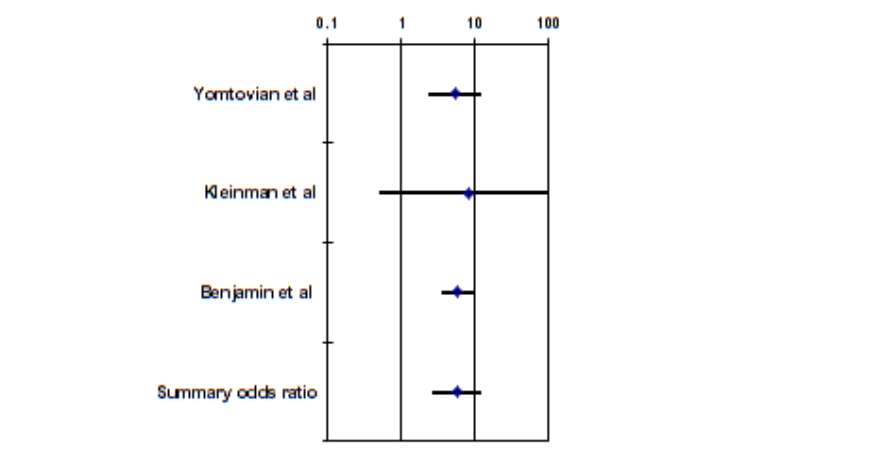
FIGURE 1. True bacterial contamination of PWBD platelets manufactured by the PRP method in the U.S. vs. single-donor platelets cultured simultaneously under the same conditions. The figure shows the results of the three available studies[23,24,25] as the summary OR of bacterial contamination in PRP PWBD vs. single-donor